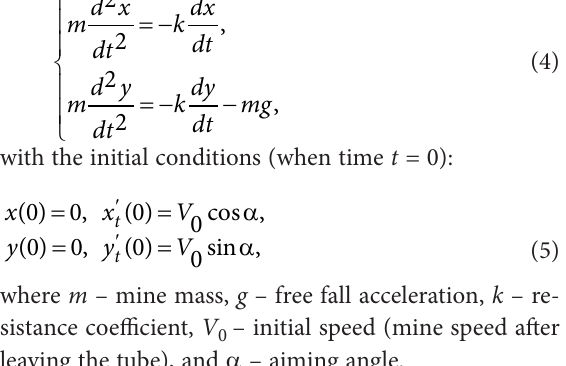
Fig. 3. Path of a bullet fired in a mountainous area (downward direction). The aiming line is reflected in hyphens. The maximum height of the path (dotted line) h max = 6.8 m, the aiming angle is 3 ° (sight 50 thousand)